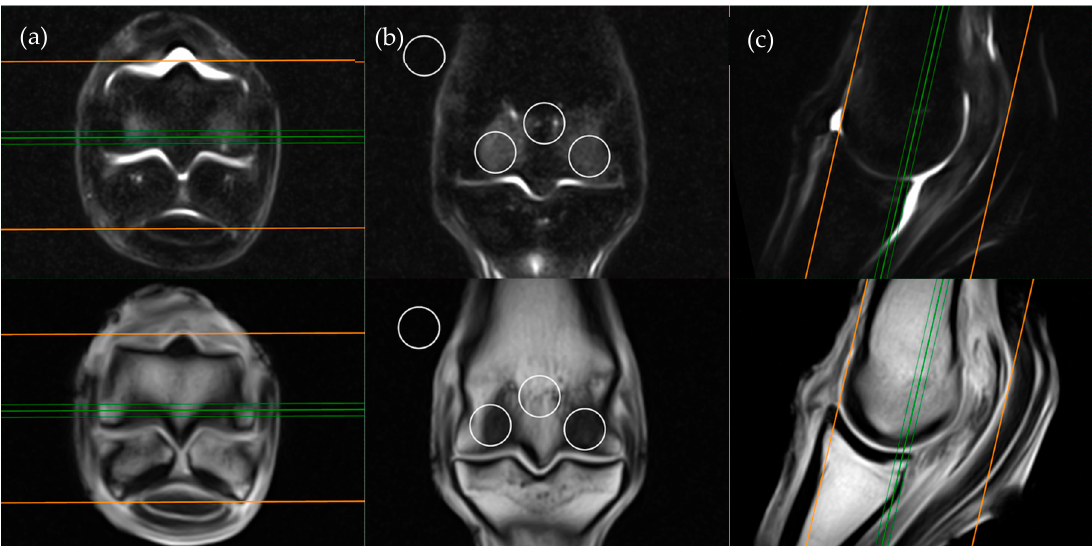
Figure 1. Short tau inversion recovery (STIR) fast spin echo (FSE) (top row) and T1-weighted (T1W) gradient recalled echo (GRE) (bottom row) MRI images in ( a ) transverse; ( b ) frontal and ( c ) sagittal planes; demonstrating the location of ROI placements in a frontal plane. The green lines on the transverse and sagittal images show the standardized orientation and location of the frontal slice for regions of interest (ROI) placement. The orange lines show the extent and orientation of all the frontal slices acquired in the MRI study.